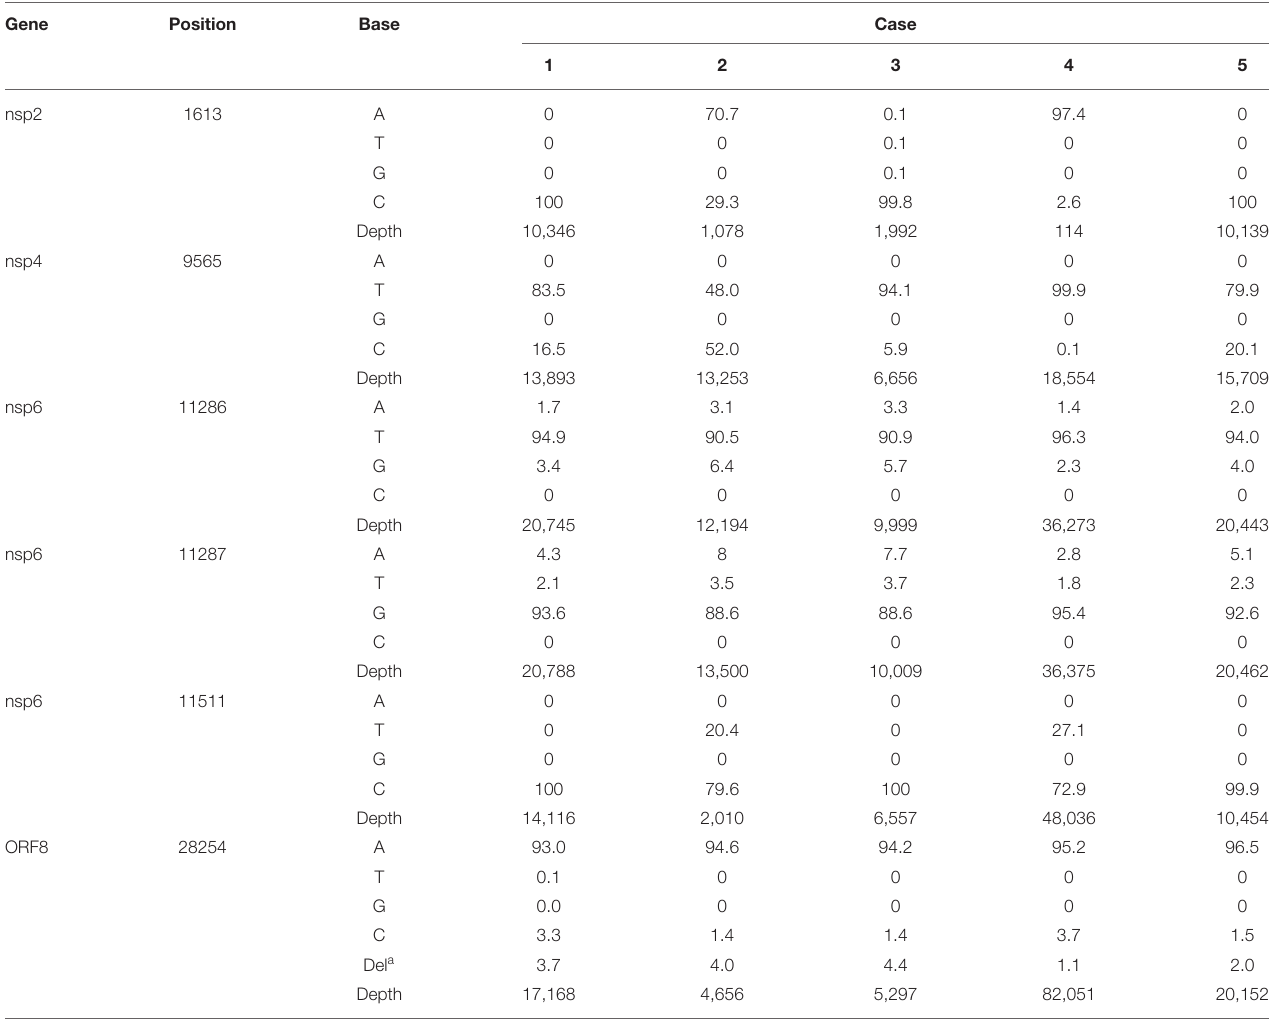
TABLE 3 | List of shared active mutation sites of the five pediatric cases with base composition in percentage of total reads. Gene Position